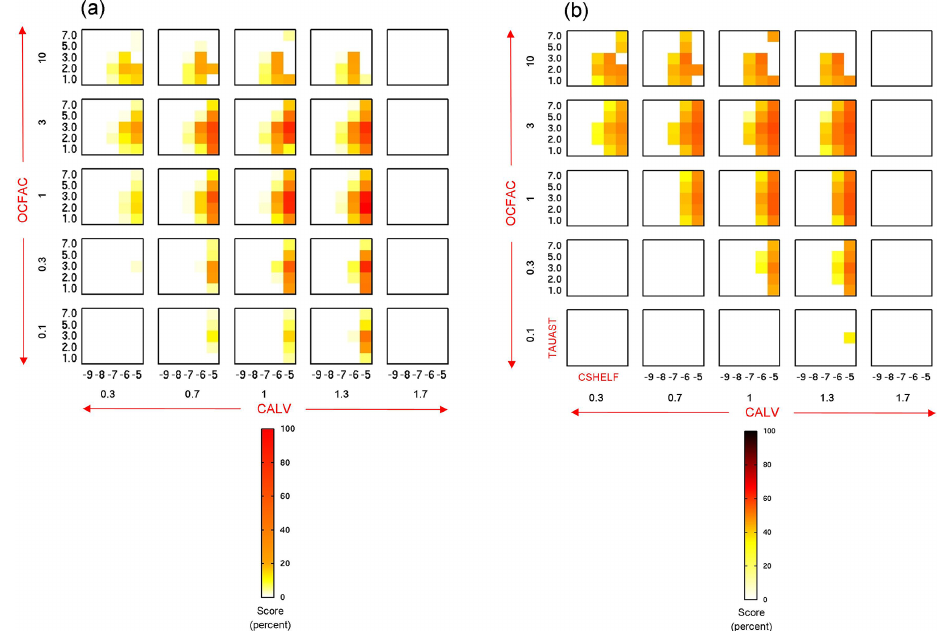
Figure C1. Aggregate scores for the complete large ensemble suite of runs (625 runs, 4 model parameters, 5 values each), used in the simple method with score-weighted averaging. The organization of the figure regarding the 4 parameter ranges is as described in Fig. 2. (a) Using close-to-Gaussian scoring approach (a) (Sect. 2.4, Appendix B). The score values in this plot are normalized relative to the maximum score of the LE, and the color scale is adjusted to illustrate the similar qualitative distribution to (b) . (b) Using the more heuristic approach (b) (Sect. 2.4, Appendix B), exactly as in Fig.